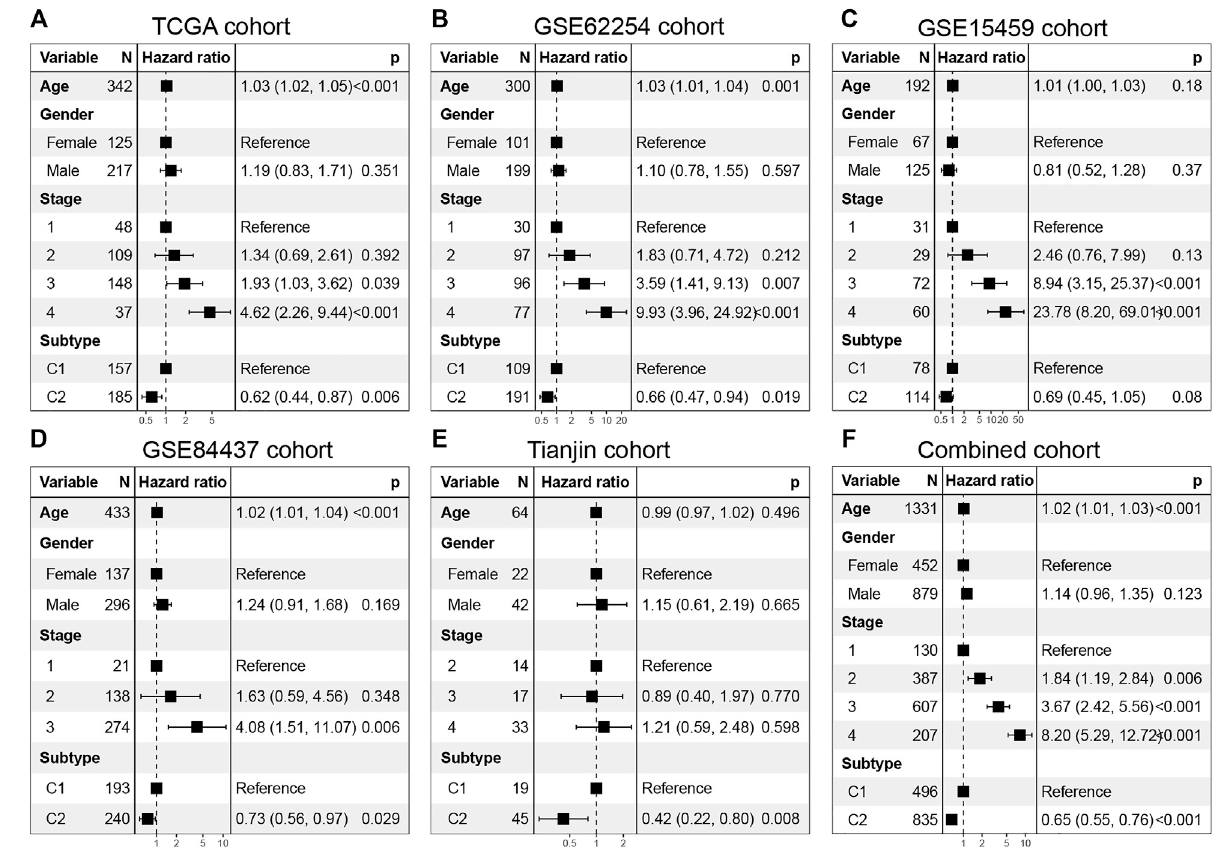
Frontiers in Genetics |